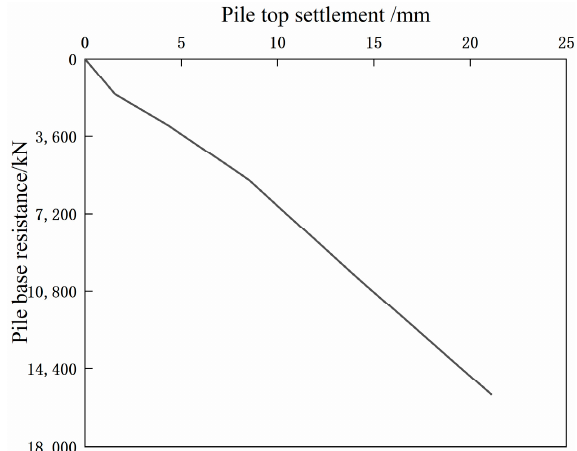
Figure 15. T-z curve of the friction resistance of the middle pile base. Figure 16 is the ratio curve of end resistance to average friction resistance. As can be seen from the figure, when the load is small, the load is mainly transferred by friction resistance; the end resistance value is relatively small. With the gradual increase in the load, the load is continuously transmitted downward through friction resistance, the relative displacement between the soil and the pile continues increasing, and the soil at the pile end is compressed to produce base resistance, which is manifested as increasing base resistance. This reveals that the friction resistance acts earlier than the base resistance.